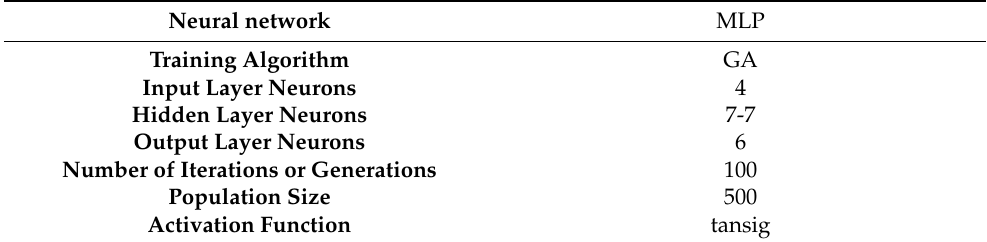
Table 2. The specifications of the GA algorithm for initial modeling of the